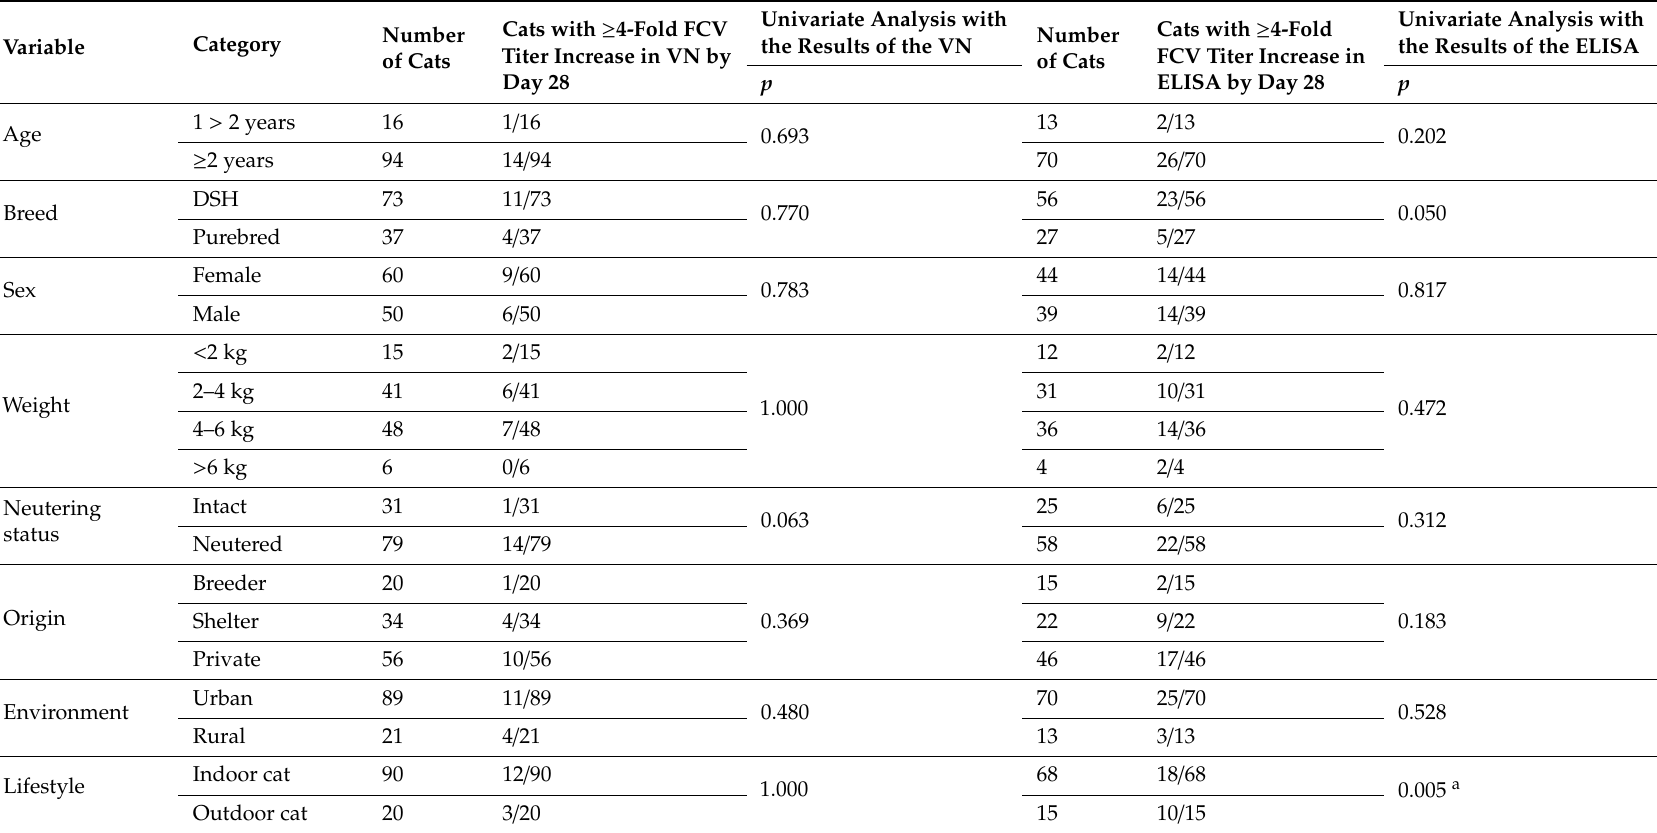
Table 2. Factors associated with ≥ 4-fold antibody titer increase in VN and ELISA after vaccination against feline calicivirus by Day 28 when compared to Day 0. Variable Category